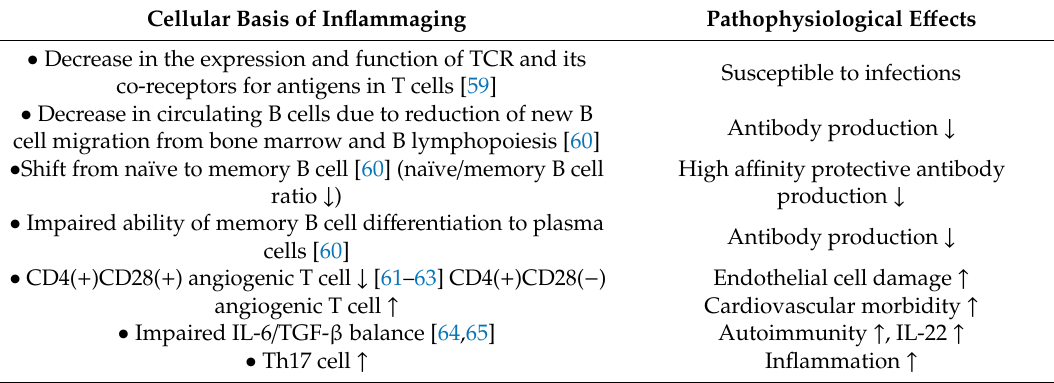
Table 2. The cellular bases of inflammaging and its pathophysiological e ff ects on patients with